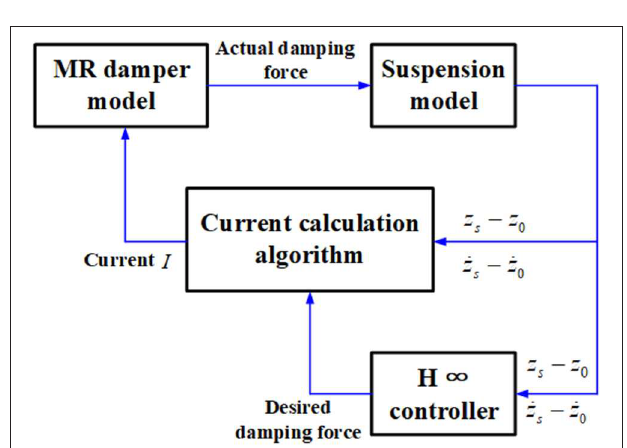
FIGURE 12 | Schematic diagram of control